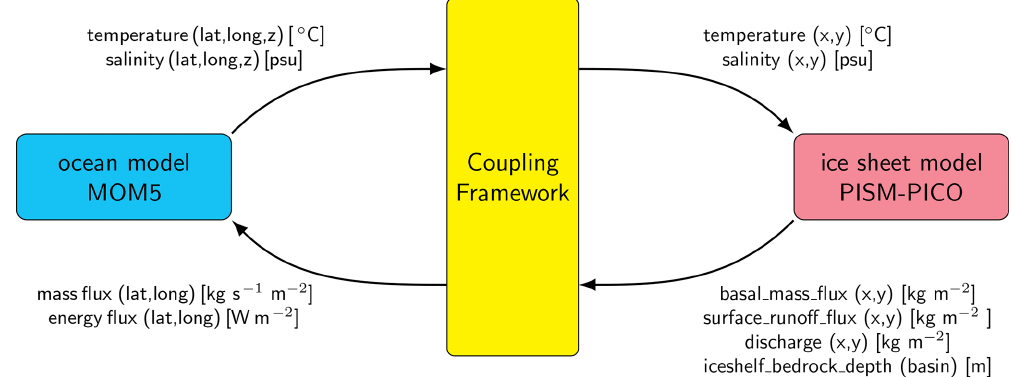
Figure 2. Overview of the coupling framework showing the input and output variables for the MOM5 ocean component and the PISM ice sheet component. Dimensions of variables are given in parentheses, and units are given in square brackets. The (lat, long) coordinates refer to the spherical ocean component grid, and the (x,y) coordinates refer to the Cartesian ice sheet component grid.